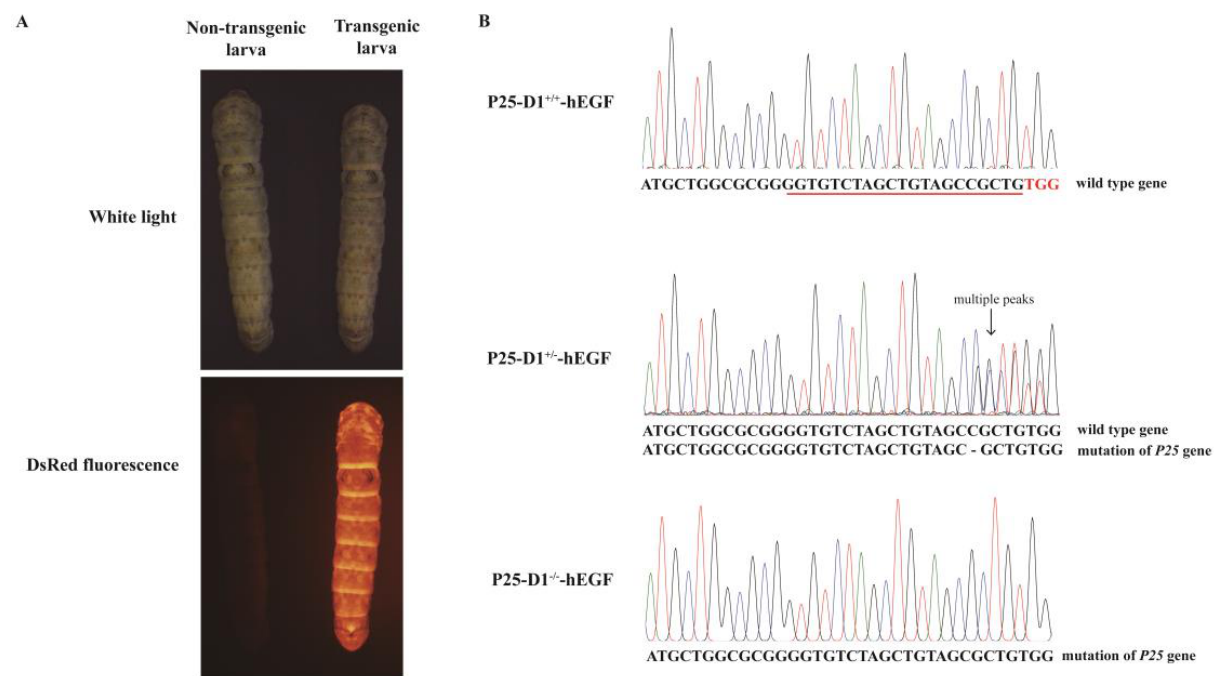
Figure 4. Production of transgenic silkworms in a P25 gene knockout background. ( A ) Screening for positive transgenic silkworms by red fluorescence detection. ( B ) Sequencing of PCR products: sequencing of silkworm exuviation genomic DNA to detect the genotype at the P25 locus. The sequence underlined in red in the P25-D1 +/+ -hEGF group (upper) was the target site of sgRNA (small guide RNA) for CRISPR/Cas9 (Clustered regularly interspaced short palindromic repeats/an associated protein (Cas9)) editing in our previous research, and the three bases TGG in red was the protospacer adjacent motif (PAM) sequence for Cas9 recognition. The multiple chromatogram peaks at the region flanking the PAM sequence in the P25-D1 +/ − -hEGF group (middle) suggests the successful generation of a heterozygous P25 gene mutant (black hyphen in the sequence represents the deleted base). The single peak in the chromatogram with a different sequence from wild type at the region flanking the PAM sequence in the P25-D1 − / − -hEGF group (bottom) suggests the generation of the homozygous P25 gene mutant.